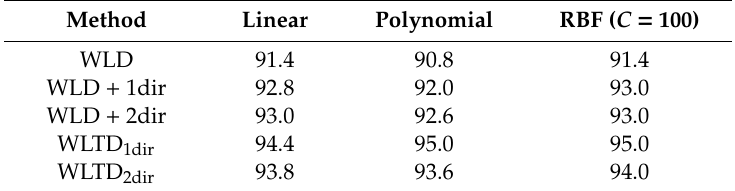
Table 2. Comparison of experimental results between WLD and WTLD of Sobel mask.